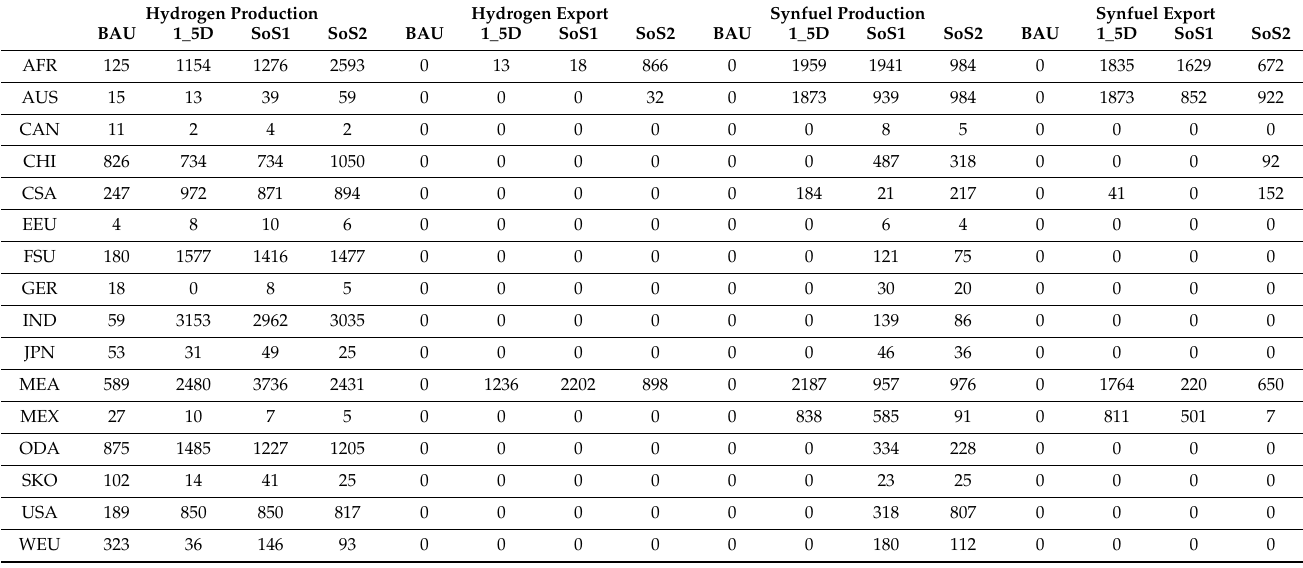
Table A4. Production and export amounts of hydrogen and synfuels. All values in